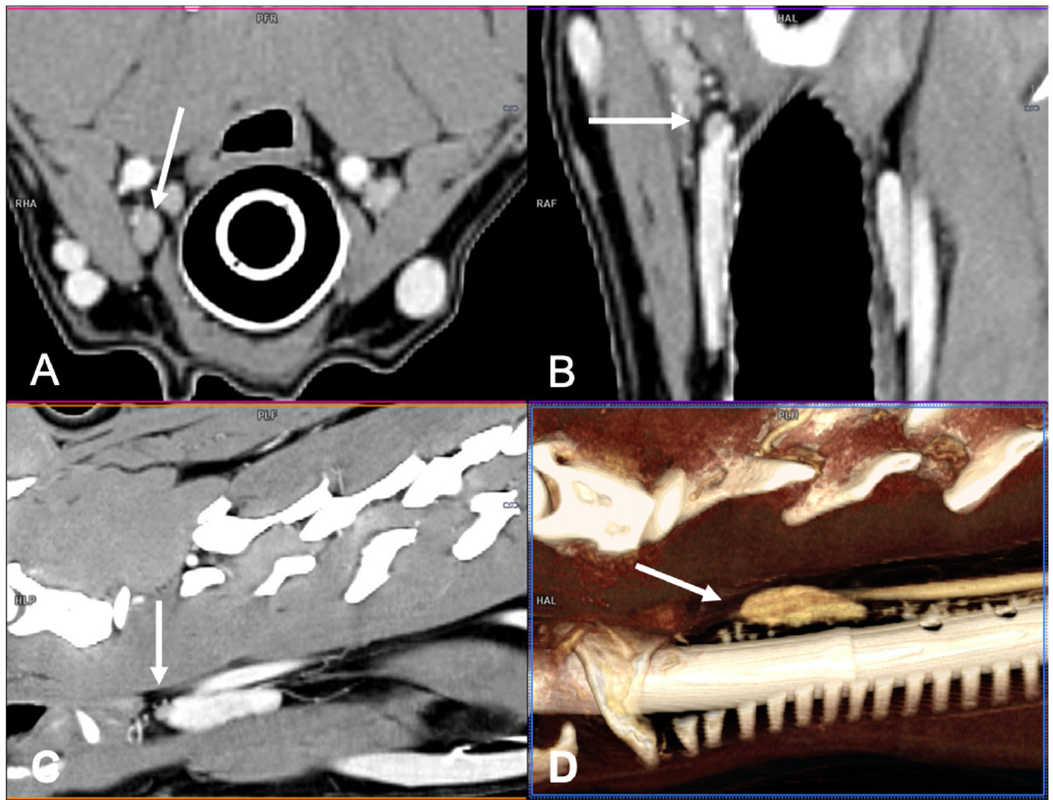
Figure 1. Visualization of a normal right external parathyroid gland in a dog, post-contrast images. Two different 3D image volume techniques were used: multiplanar reformation (MPR), in which the three orthogonal imaging planes are seen ( A ) transverse plane; ( B ) dorsal plane; and ( C ) sagittal plane, and volume rendering (VR) technique (parasagittal view) ( D ).